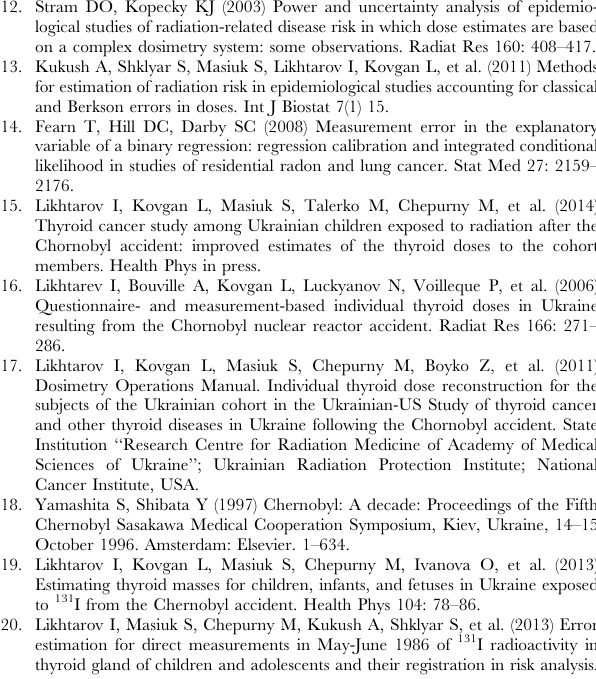
Figure S1 Comparison of TD-02 [ 3 ] and current (TD-10) dose estimates. Current (TD-10) dose vs TD-02 dose. (TIFF) Figure S2 Comparison of TD-02 [ 3 ] and current (TD-10) dose estimates. Current (TD-10) dose vs TD-02 dose. Ratio current (TD-10) dose:TD-02 dose vs TD-02 dose. (TIFF)